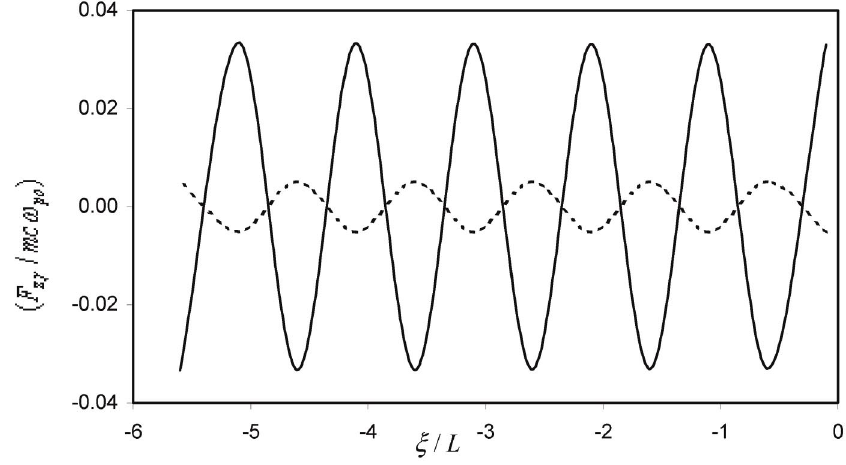
FIG. 4. Variation with (cid:29)=L of normalized axial (solid curve) and transverse (dashed curve) forces acting on a test electron behind the matched laser pulse propagating through the plasma channel for a 2